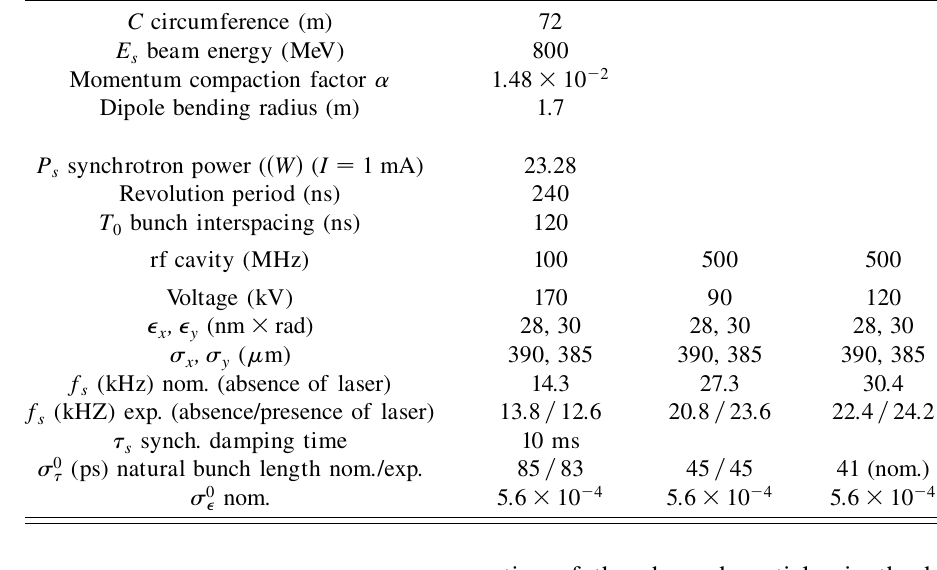
TABLE I. Main Super-ACO storage ring characteristics. Horizontal and vertical emittances ; (cid:2) ; (cid:1) ) and beam transverse dimensions ( (cid:1) ) at the center of the optical klystron. At the ( (cid:2) x y x y dipole placed in front of the FEL straight section the values of the dispersion function (cid:9) are 0.364 and 1.528 m, respectively. f is the synchrotron of the beta function (cid:10) x s